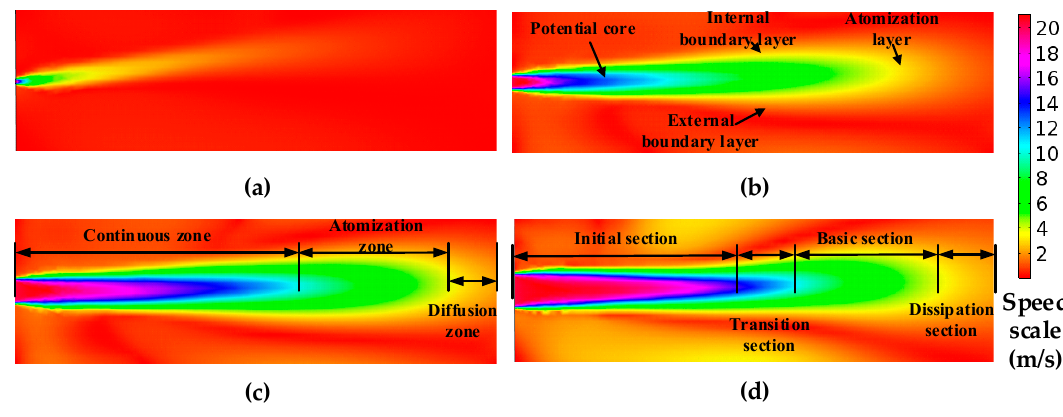
Figure 3. Steady-state flow field velocity cloud map with different leakage hole (at 0.3 Mpa). (a) 20 m; (b) 60 m; (c) 100m; (d) 140 m. The variations of the jet centerline velocity with different inlet velocities and different leakage holes are shown in Figure 4.